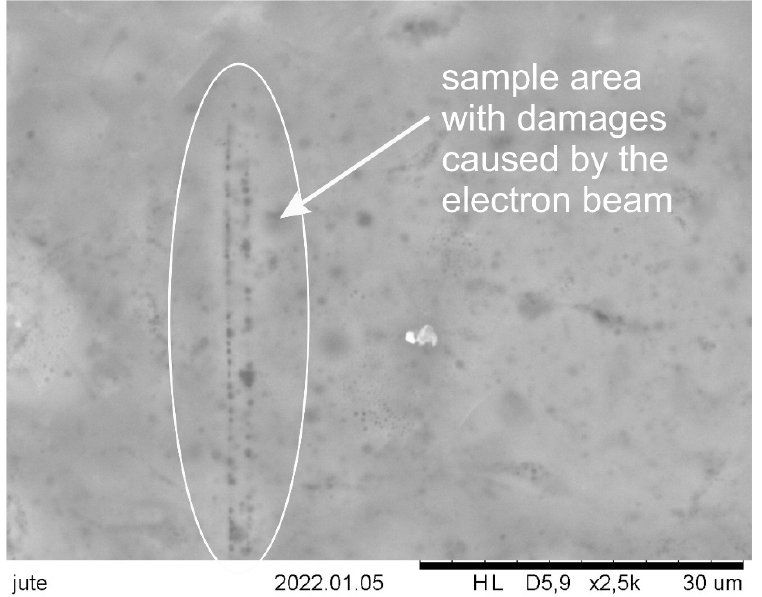
Figure 2. SEM image of a polybag with jute fibers; shown as an example for damaging the sample surface using the electron beam during SEM measurements.